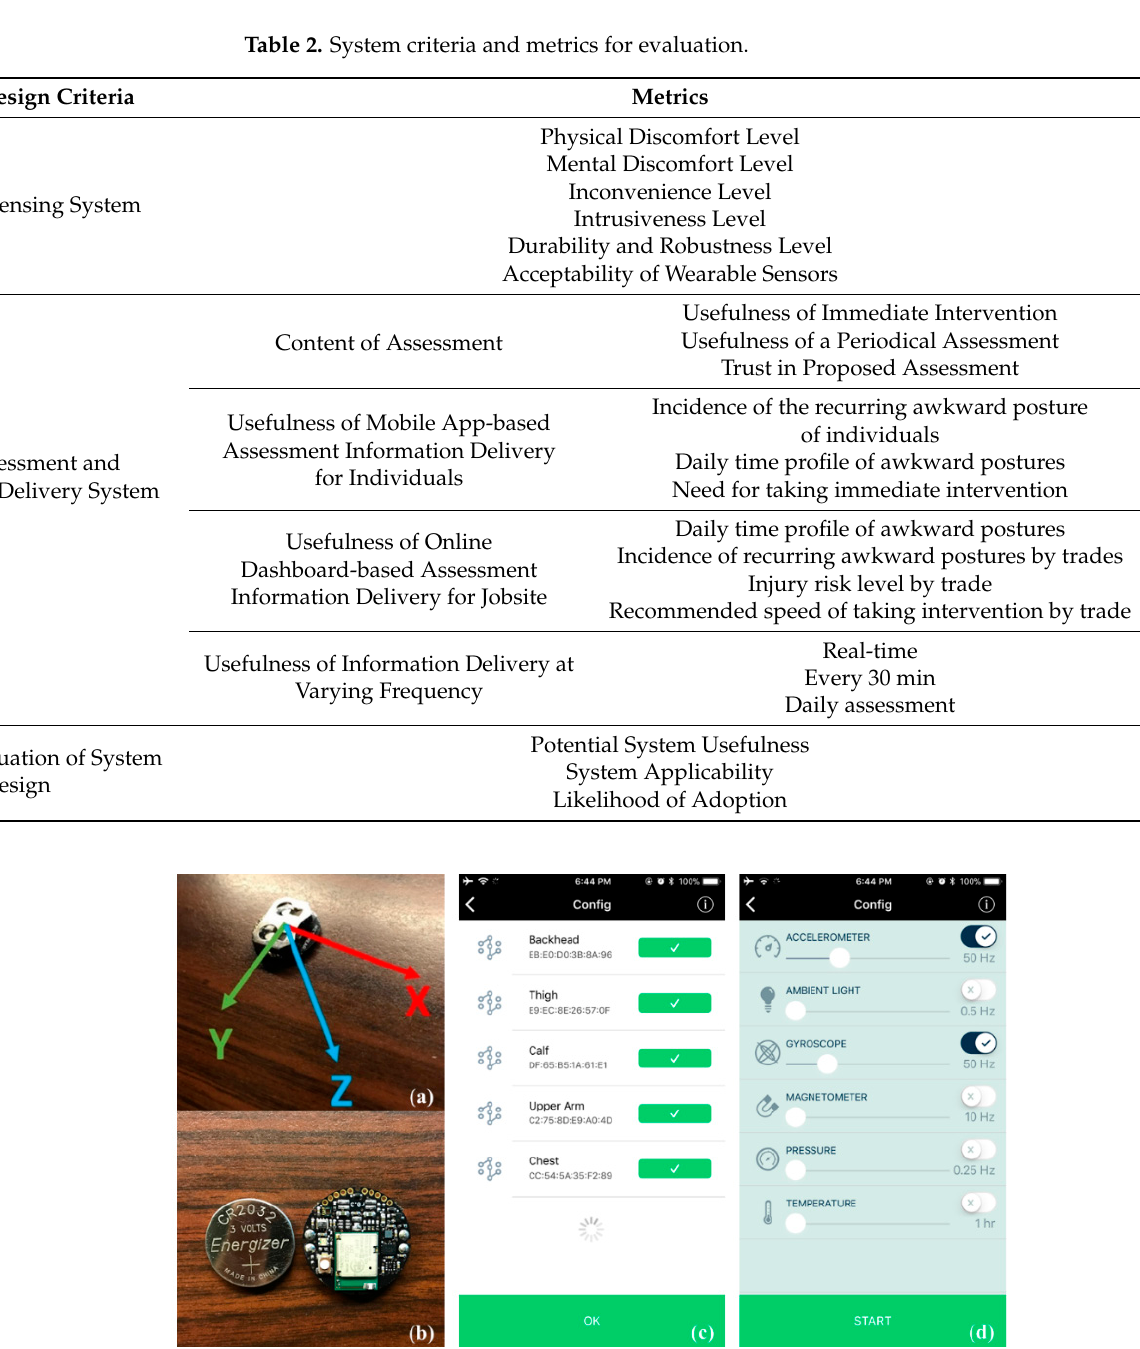
positive direction in each axis, ( b ) sensor board and battery, ( c ) and ( d ) are the MetaBase interfaces